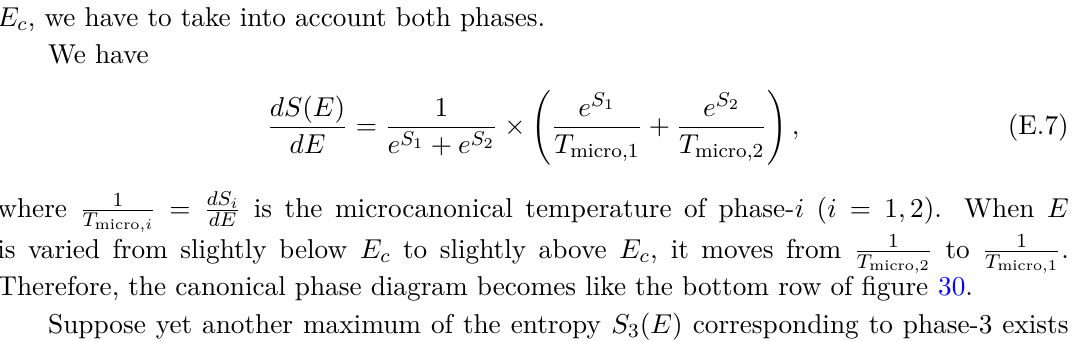
Figure 30. [Top] Coexistence of two local maxima of entropy S 1 ( E ) and S 2 ( E ) corresponding to phase-1 and phase-2 in the microcanonical ensemble. We assume that S and S ( E ) < S ( E ) at E < E . [Bottom] Corresponding canonical phase diagram; free energy 1 2 c minimum (left) and maximum